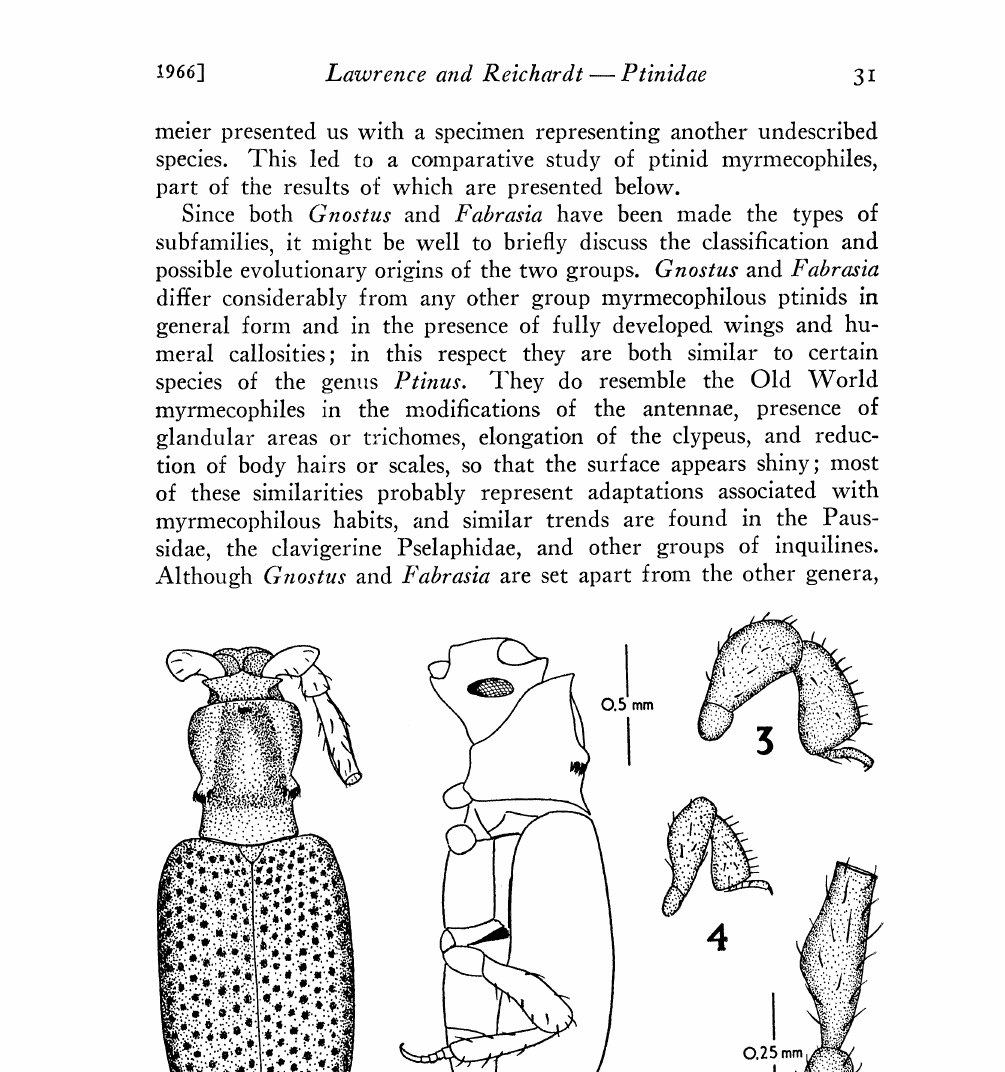
Figs. 5. Gnostus flor;.danus Blatchley (trom Plantation Key, Florida), Fig. 1, dorsal view; Fig. 2, lateral view; Fig. 5, antenna; Gnostus meinerti Wasmann (from Barro Colorado Island, Panama), Fig. 3, hind leg; Gnostus ]ormicicola Westwood (leetotype), Fig. 4, hind